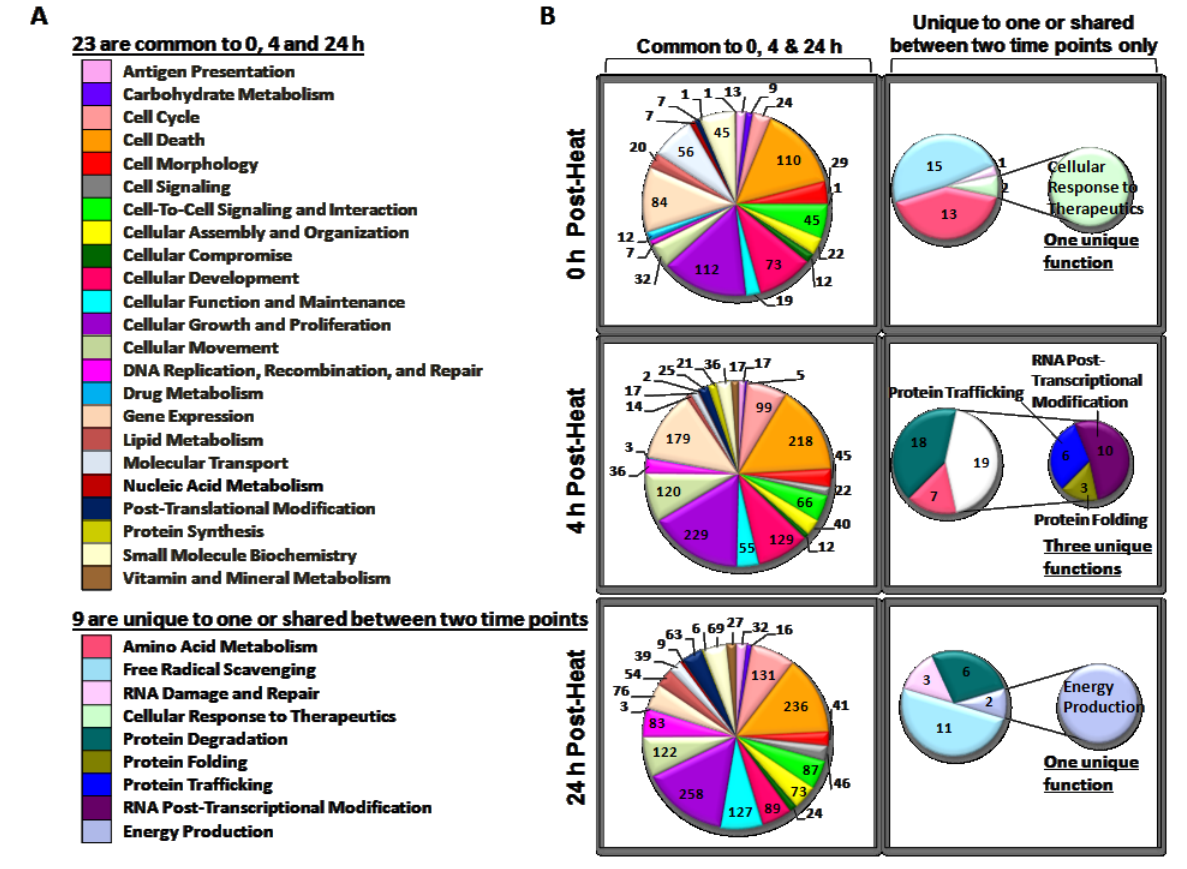
Figure 3. Diagrams of cellular and molecular functions associated with genes expressed in human epidermal keratinocyte (HEK) cells exposed to heat shock. Following an Ingenuity Pathway Analysis (IPA) core analysis, the molecular and cellular functions linked to each recovery period were sorted and illustrated. ( A ) A list of the 23 biological functions common to all three time points and nine functions unique to one time point or shared between two time points; ( B ) Pie charts of gene functions at 0, 4 and 24 h post-exposure. The pie chart sectors represent the number of genes associated with each